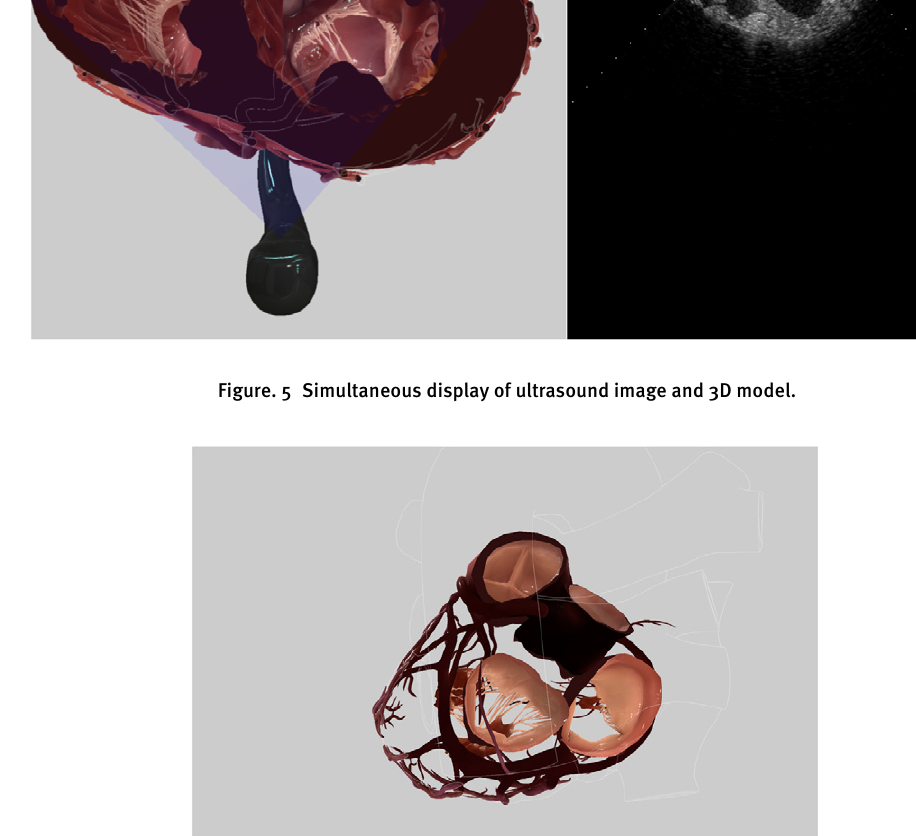
Figure. 6 Selection of intracardiac